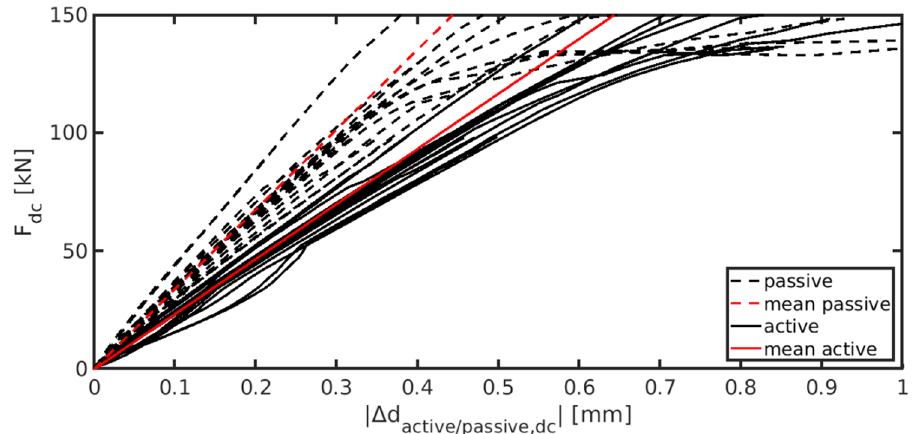
Fig. 9 Load versus displace- ment curves of the second and third loading cycles for the diagonal compression